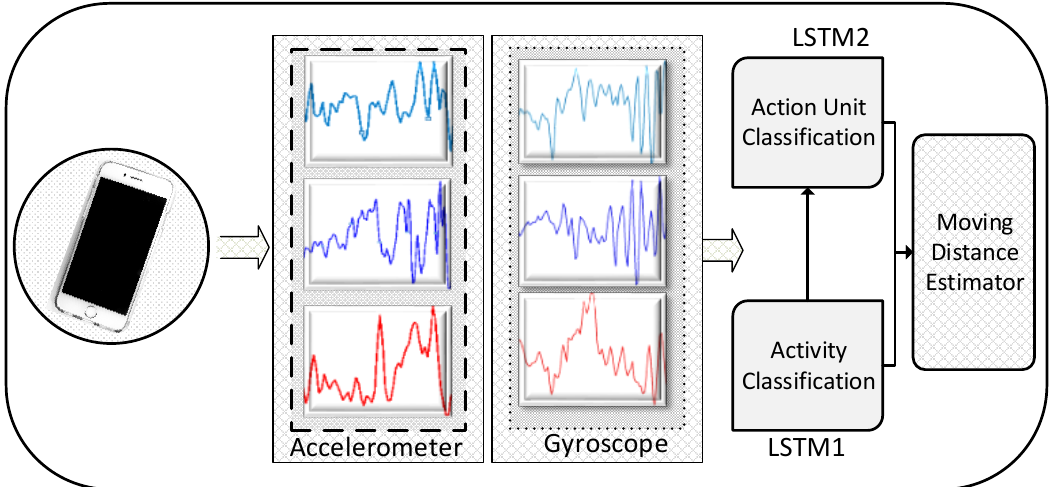
Figure 3. Architecture of the proposed indoor positioning